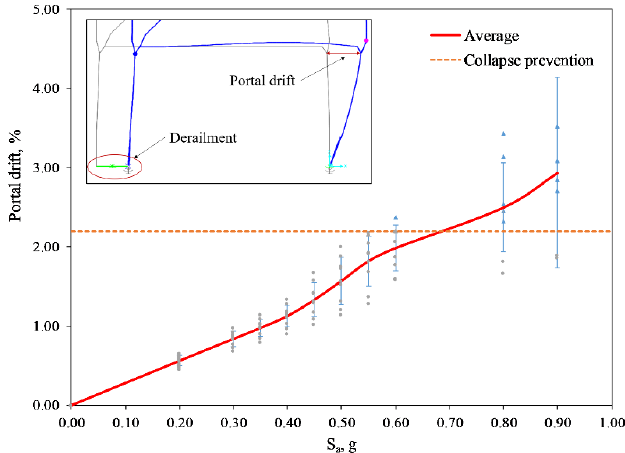
Figure 11. The portal drift of the FC boundary condition.